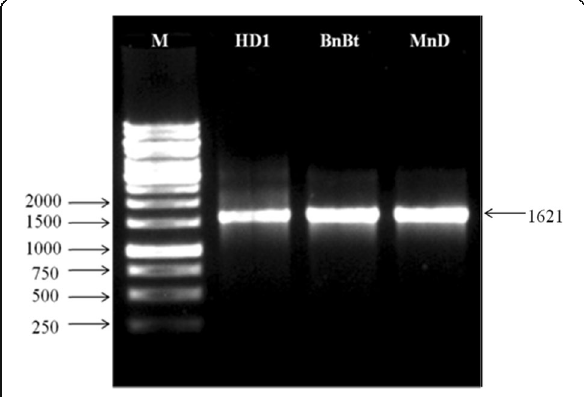
Fig. 1 The presence of Vip3 gene of Bacillus thuringiensis kurstaki BnBt and MnD strains and HD-1 strain as a positive